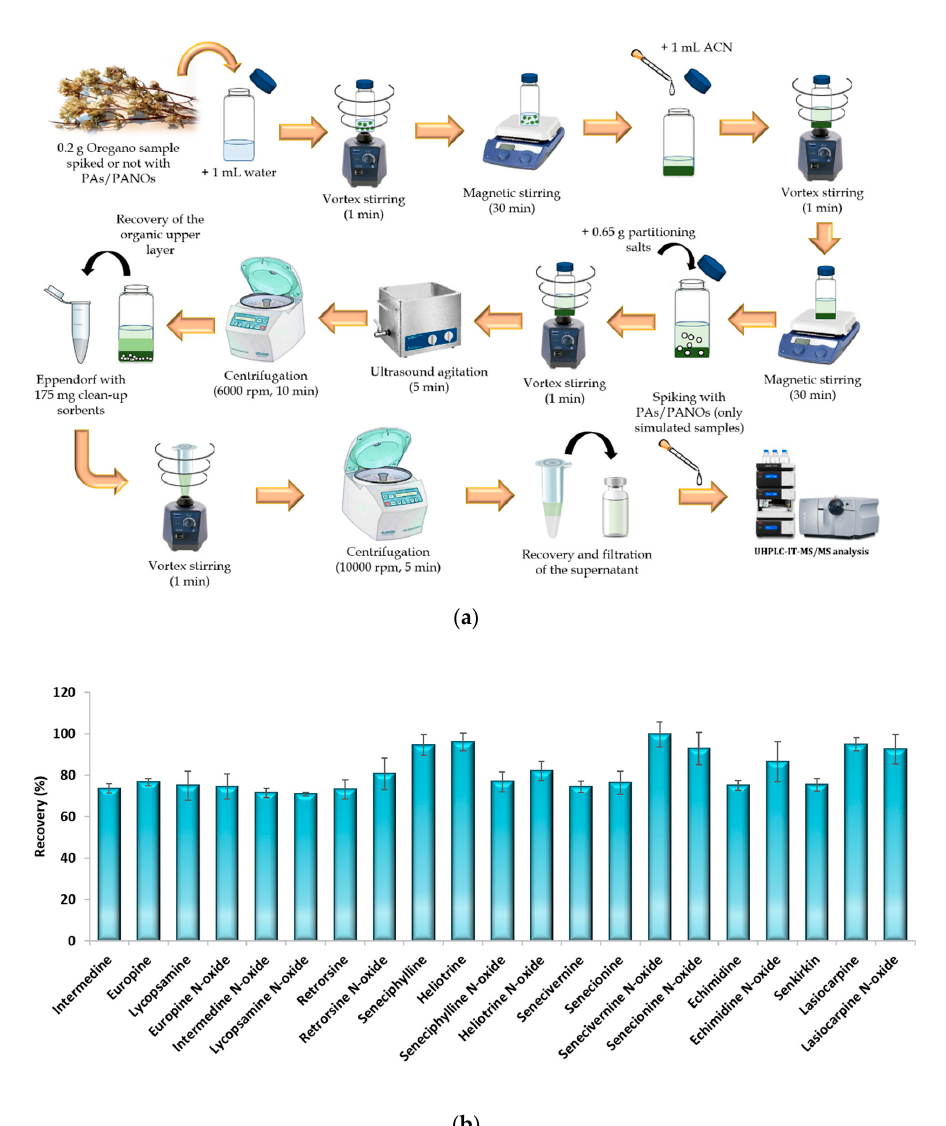
Figure 3. ( a ) Schematic representation of the µ-QuEChERS extraction procedure and ( b ) recovery percentages obtained from the analysis of three spiked replicates of an oregano sample (100 µg/kg of each analyte) extracted by the µ-QuEChERS procedure. Error bars represent the standard deviation of sample replicates ( n = 3).